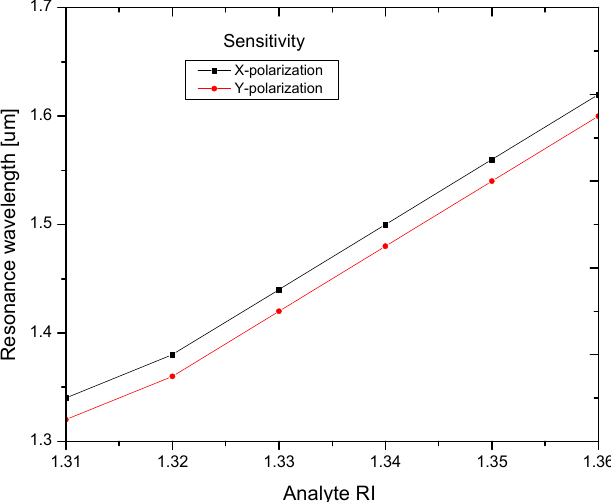
Figure 6. Sensitivity analysis of different analyte RI values for X- and Y-polarization.